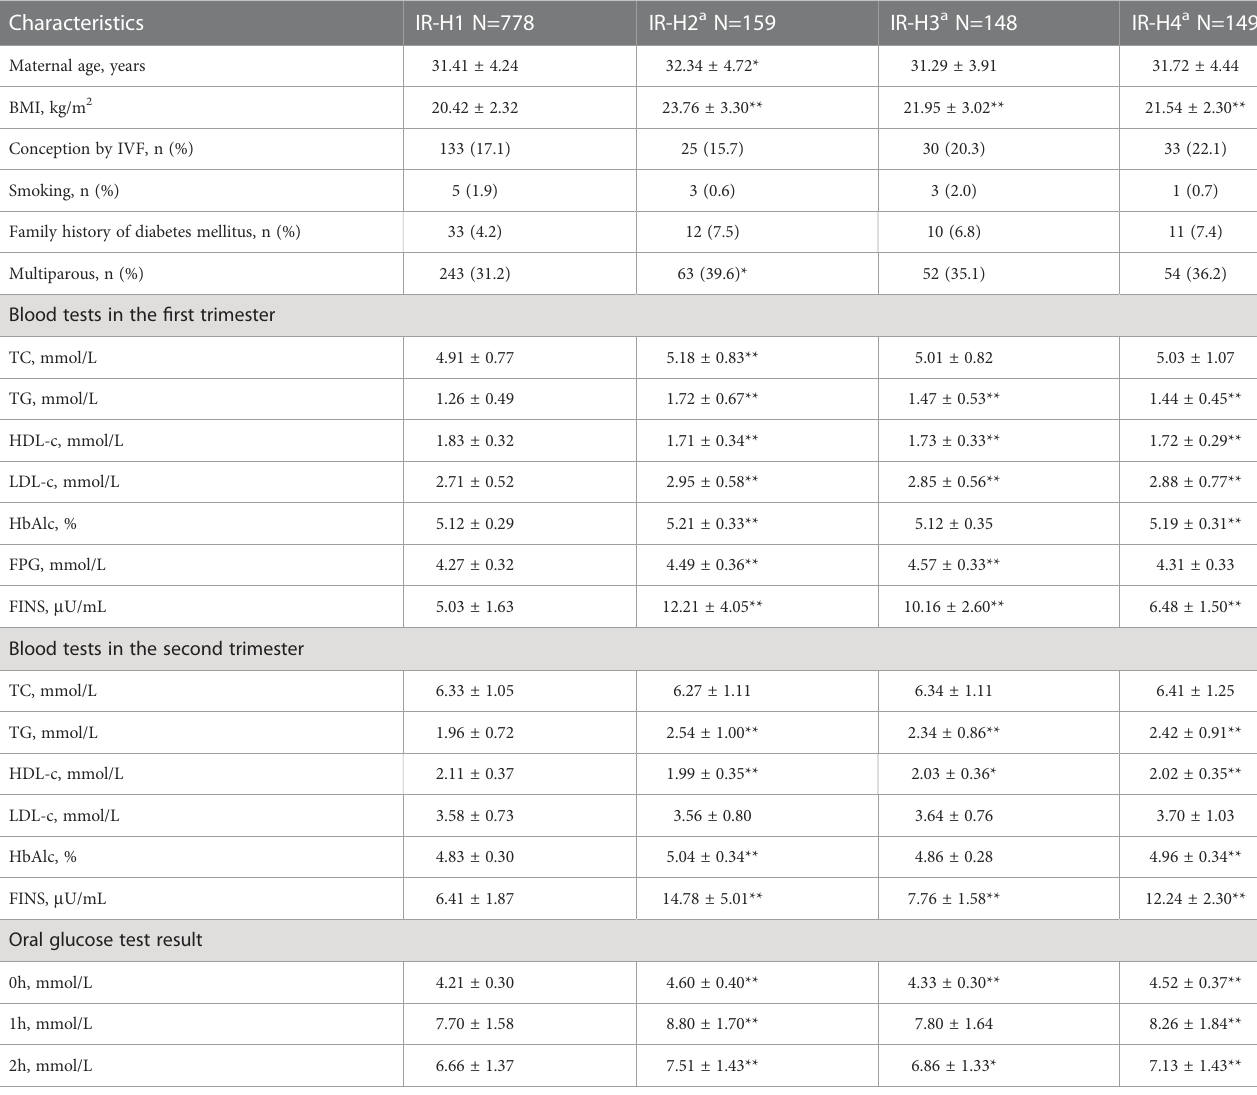
TABLE 2 Maternal characteristics, lipid pro fi les and glucose metabolism indices in different HOMA-IR subgroups.